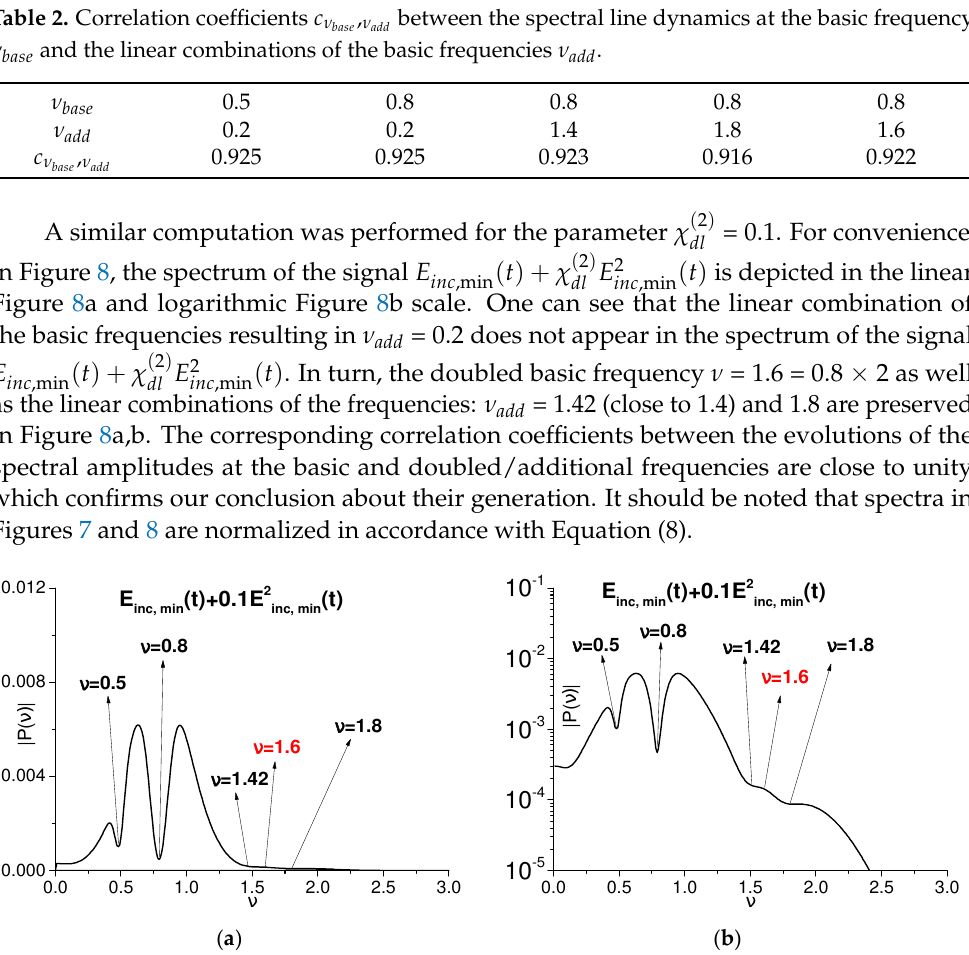
( t ) + χ ( 2 ) ( t ) at χ ( 2 ) E 2 = 0.1 in the linear ( a ) and inc ,min inc ,min dl dl